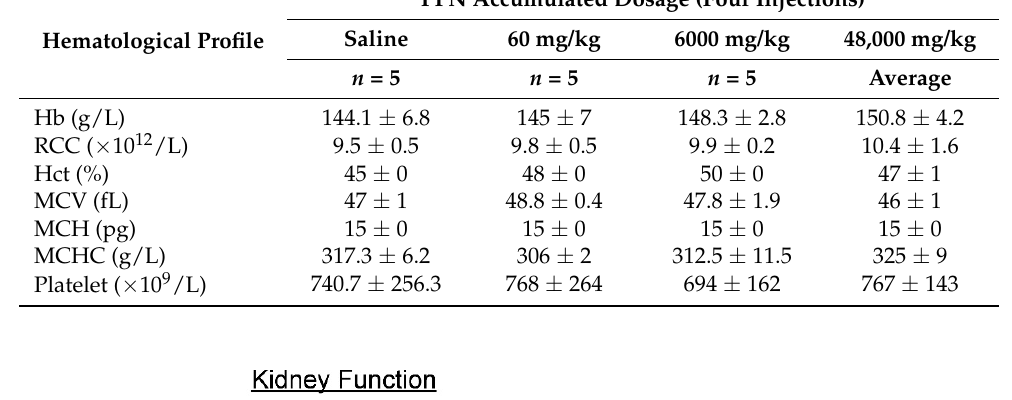
Table 4. Hematological parameters in BALB/c mice following 14 days of repeated IV administration of the PPNs. The data are expressed as mean ± standard deviation ( n = 5).